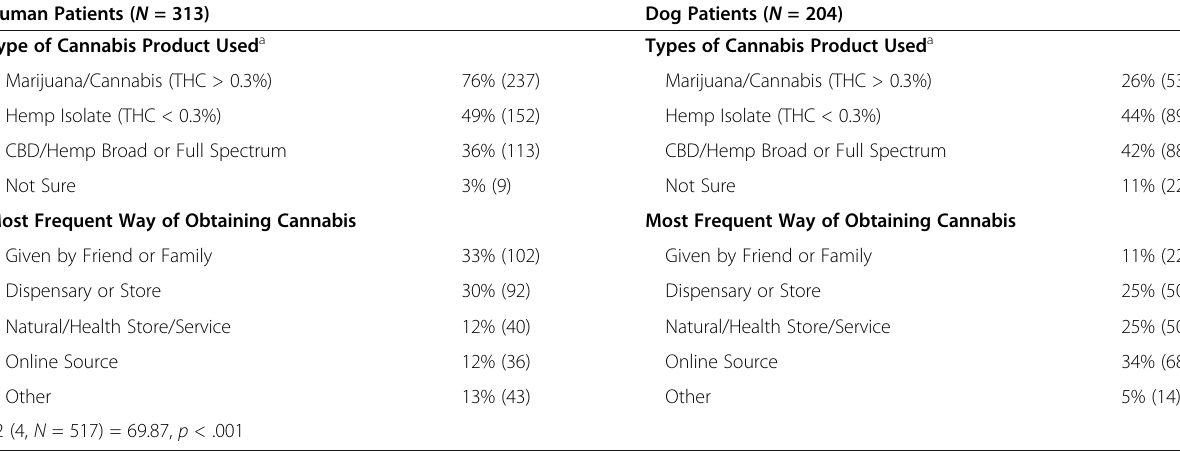
Table 2 Descriptive Information for Cannabis Products Used and Comparison for How Cannabis Products are Obtained for Human Patients and Dog Patients Human Patients ( N = 313)